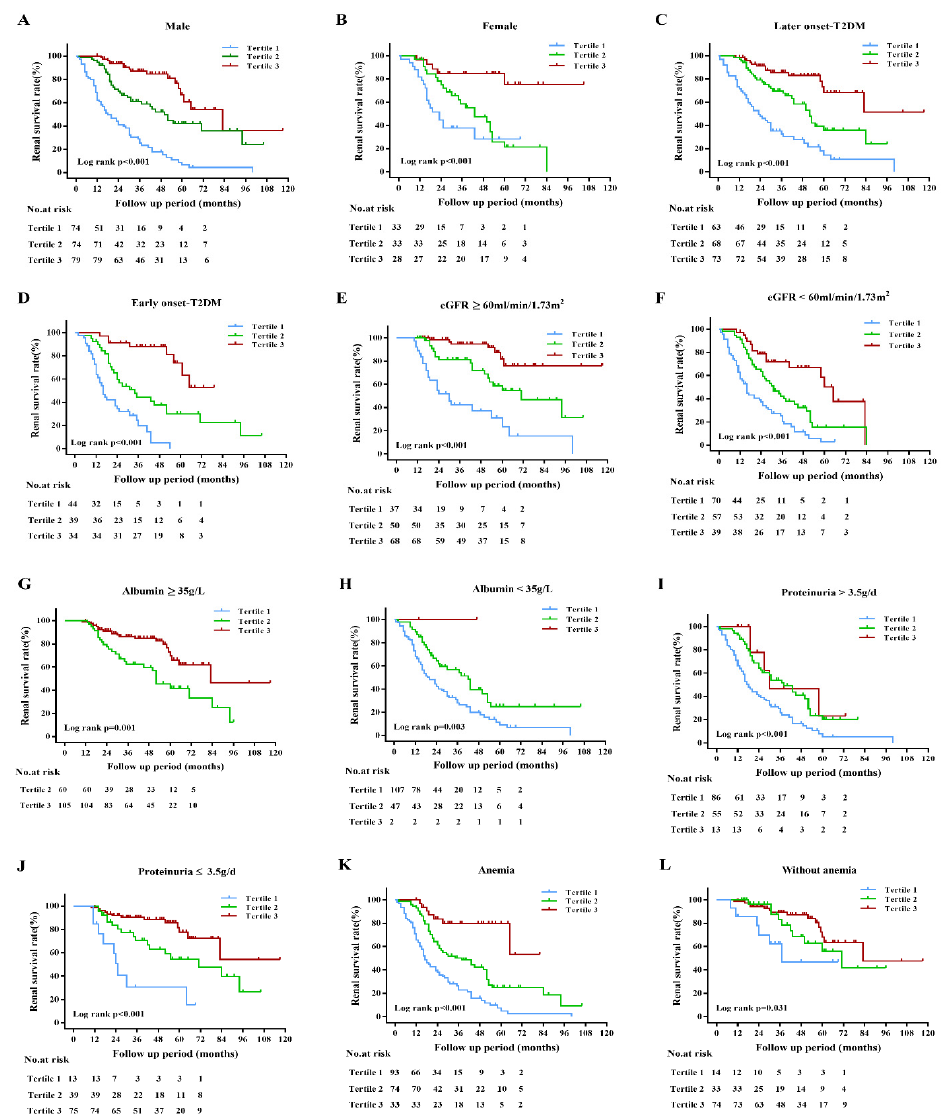
Figure 4. Kaplan–Meier curves of subgroup analysis in DN patients with different types of clinical manifestations. ( A ) The renal survival rate of male patients with different PNI tertiles. ( B ) The renal survival rate of female patients with different PNI tertiles. ( C ) The renal survival rate of DN patients with later-onset T2DM in different PNI tertiles. ( D ) The renal survival rate of DN patients with early onset T2DM in different PNI tertiles. ( E , F ) The renal survival rate of DN patients with eGFR ≥ 60 mL/min/1.73 m 2 or <60 mL/min/1.73 m 2 in different PNI tertiles. ( G , H ) The renal survival rate of DN patients with serum albumin ≥ 35 g/L or <35 g/L in different PNI tertiles. ( I , J ) The renal survival rate of DN patients with proteinuria > 3.5 g/day or ≤ 3.5 g/day in different PNI tertiles. ( K , L ) The renal survival rate of DN patients with or without anemia in different PNI